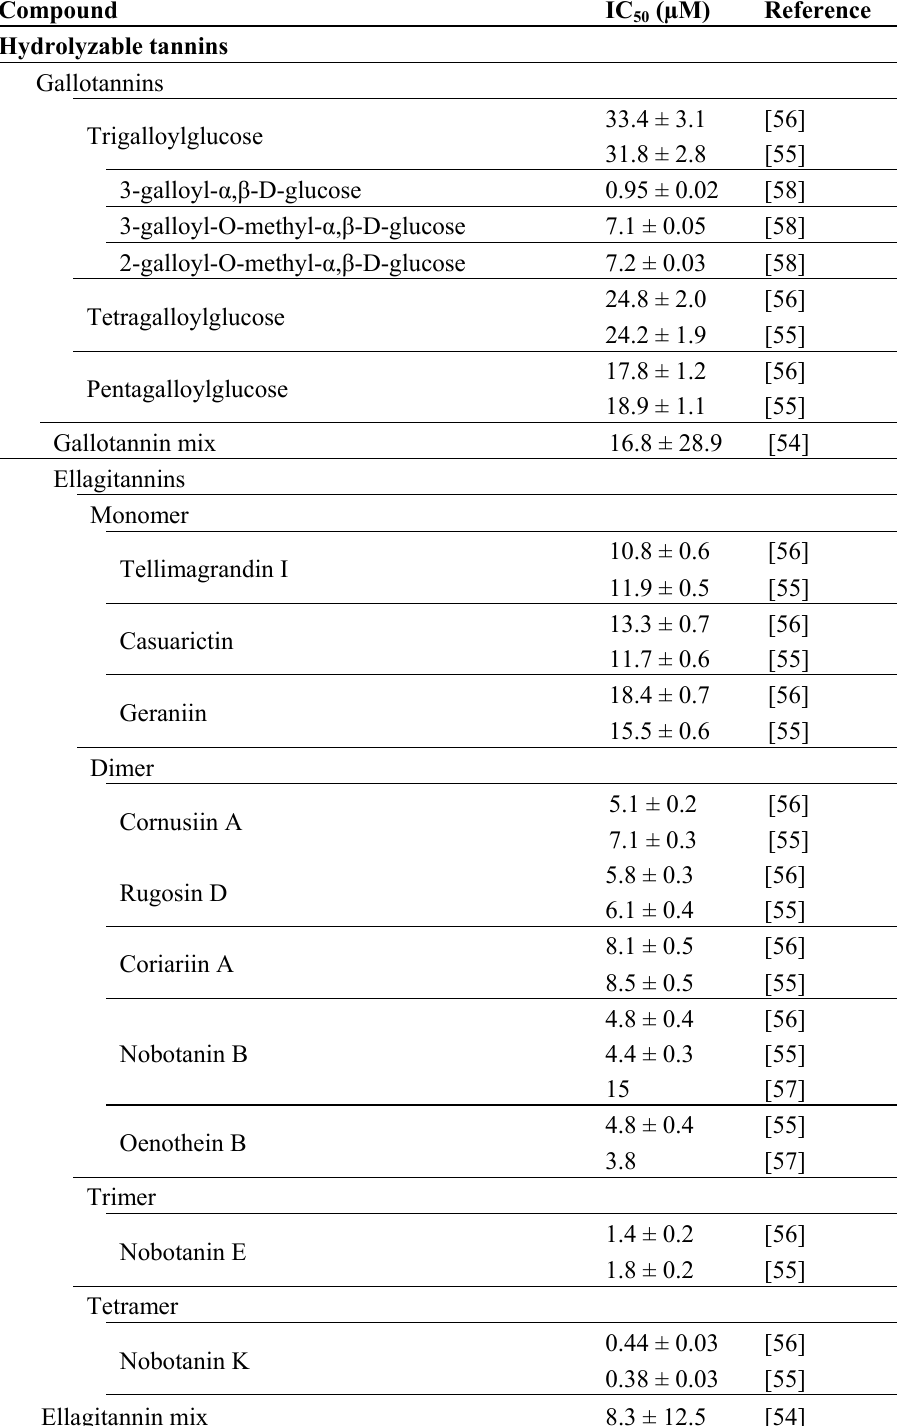
Table 1. Inhibitory potential of tannins, related molecules as well as other known PARG inhibitors in enzymatic in vitro